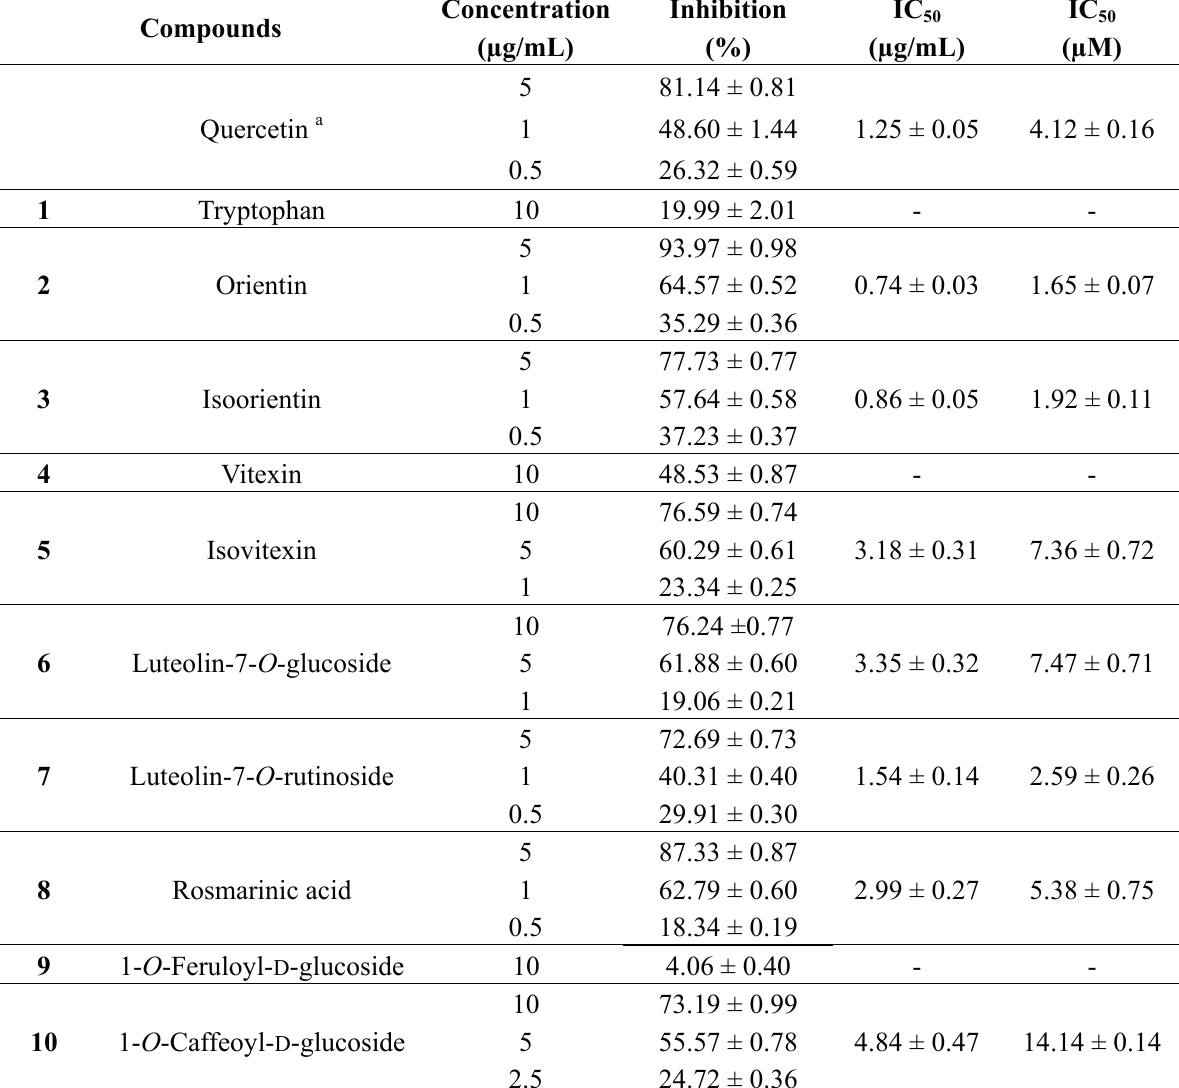
Table 2. Inhibitory effects of the constituents isolated from the Colocasia esculenta (L.) Schott on rat lens aldose reductase